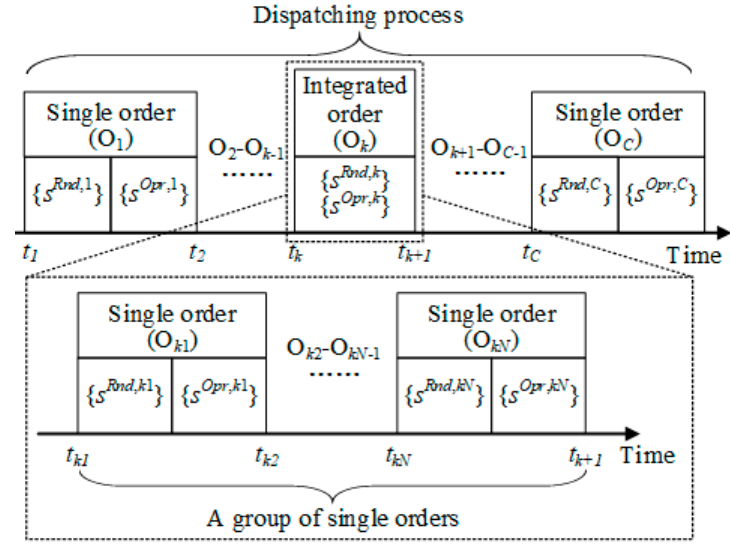
Figure 1. Analysis of the dispatching process based on a group of single